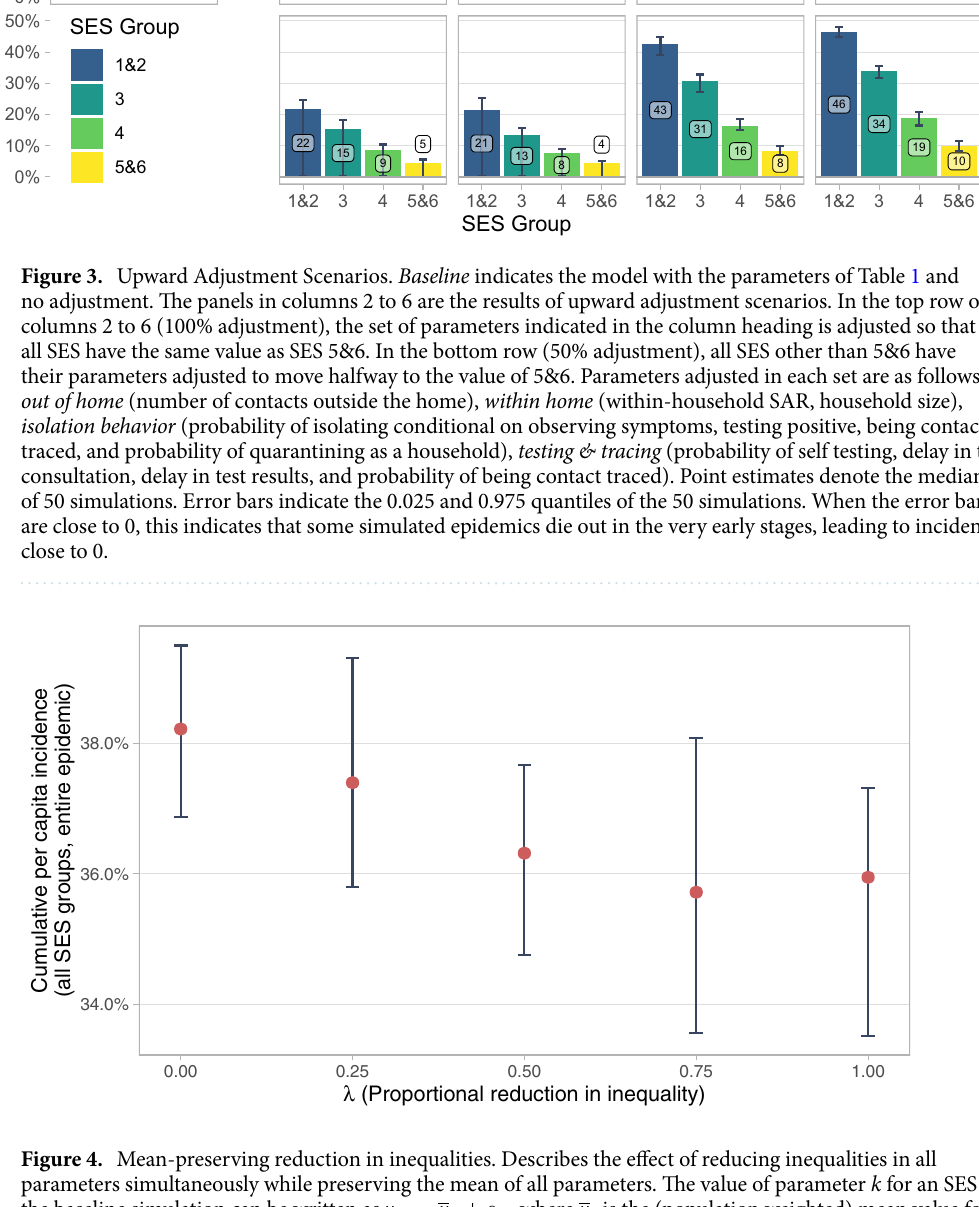
larger when targeted on the lowest SES ( p < 0.001 for all differences). If the assumptions of the model hold, policies that target socioeconomically disadvantaged populations are likely to be substantially more effective. By contrast, increased access to testing for symptomatic individuals has only a small impact on total infections, and this impact does not differ significantly if targeted or not. Access to tests is not associated with lower infec- tion rates in Bogotá, likely because of severe delays across all SES, and because initial testing coverage is limited.